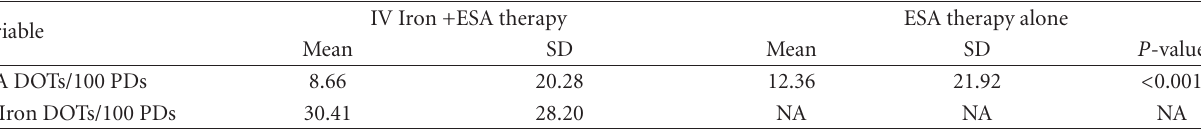
Table 7: Mean days of therapy/100 patient days by drug group.